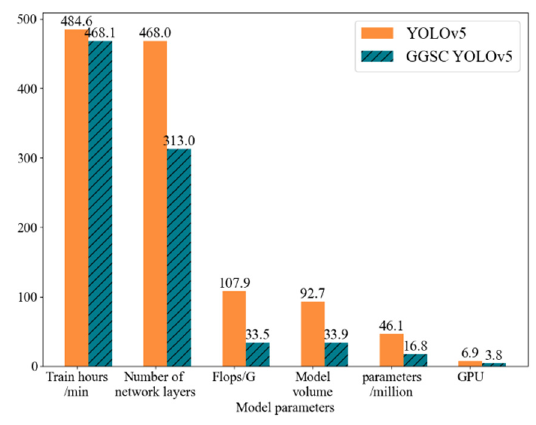
Figure 7. Comparison of the number of model parameters.